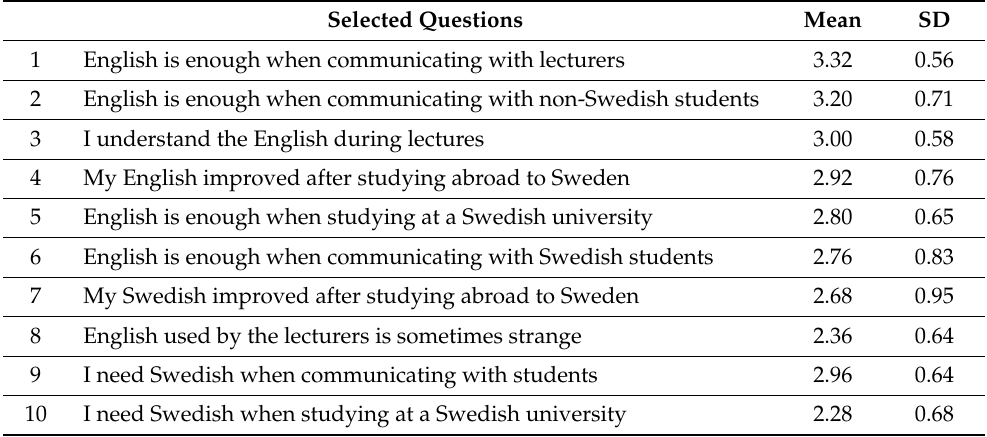
Table 1. Language use in the Swedish EMI